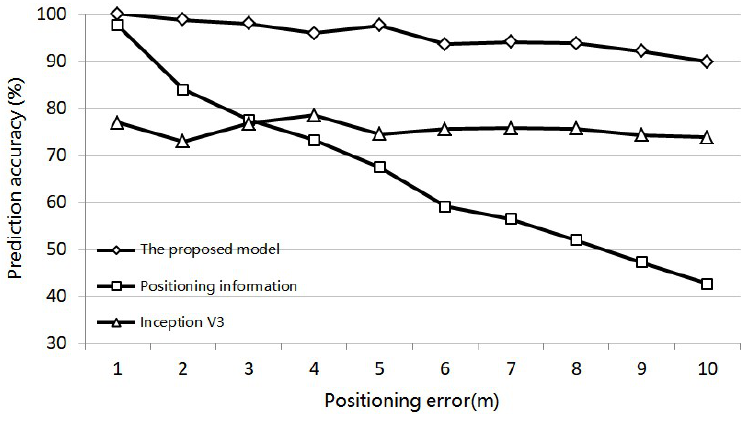
Figure 15. The prediction result of data set with different positioning error.